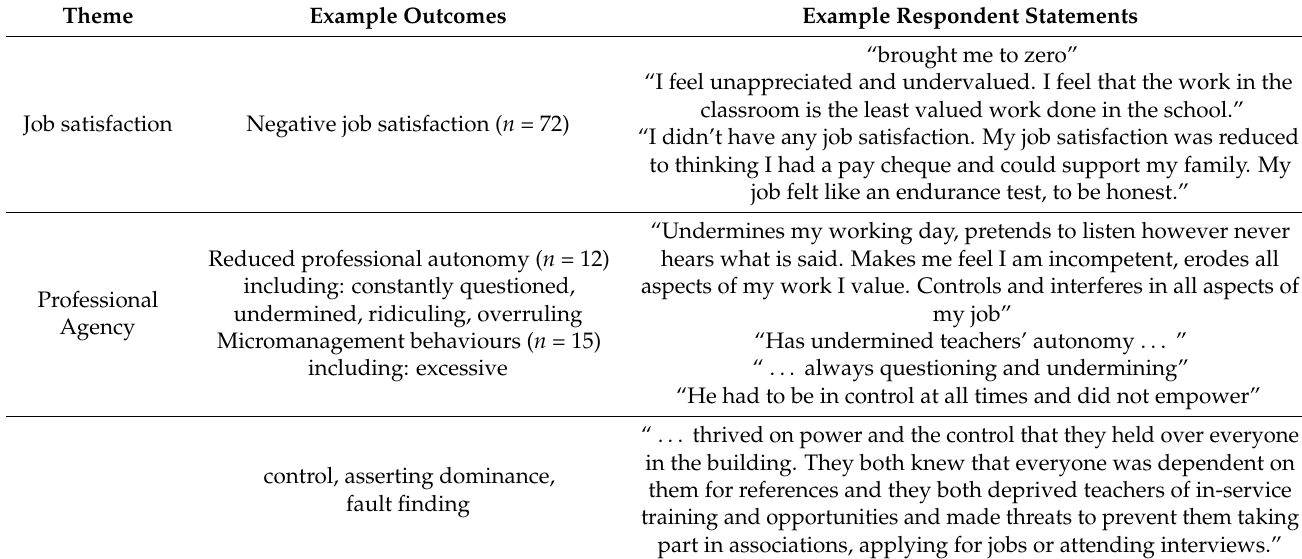
Table 8. Professional impact on participant of toxic